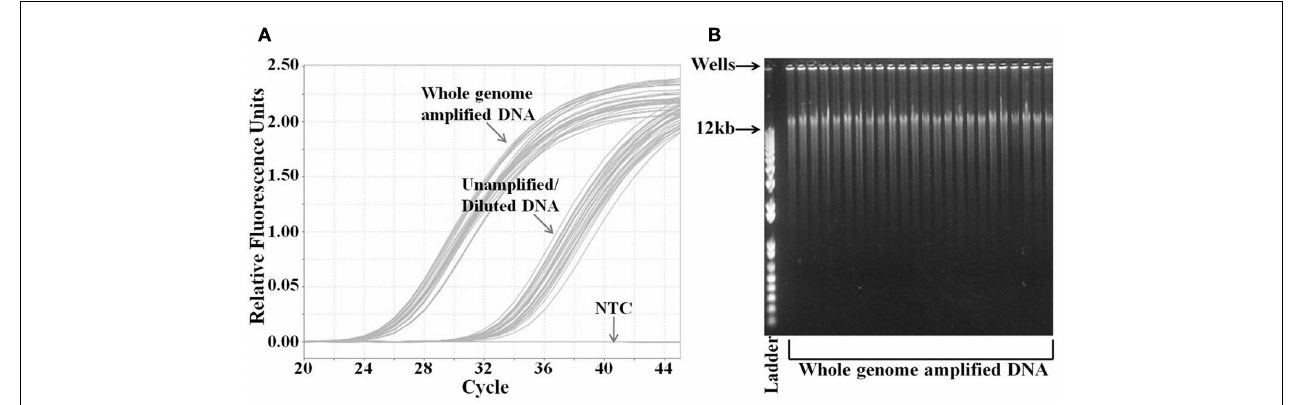
amplification. (B) Agarose gel electrophoresis analysis of the whole genome amplified DNA samples. Samples were run on 0.8% agarose gel with the DNA ladder.The highest molecular weight in the ladder is 12kb.The PCR graph and the gel image are representative of the 285 samples fromTrial 1. NTC, no template control.